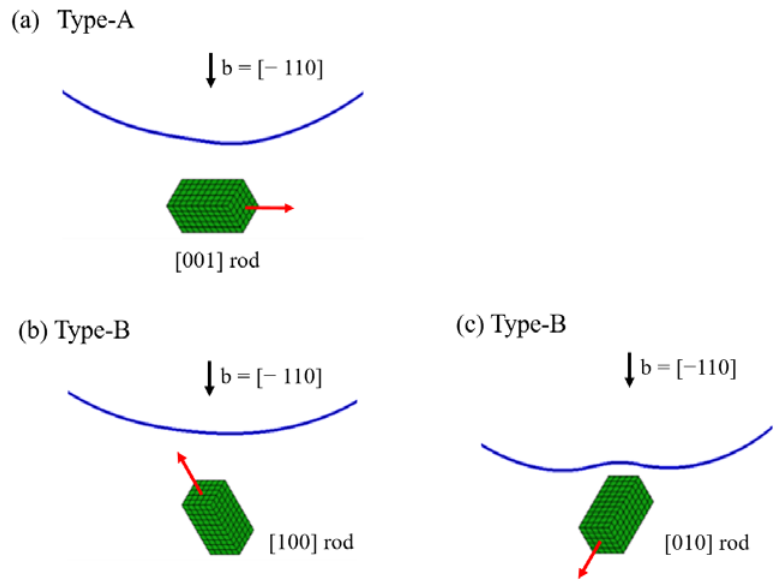
Figure 1. Rods and dislocation on the (111) slip plane. Type-A variant: dislocation Burger’s vector perpendicular to the [001] rod in ( a ). Type-B variants: dislocation Burger’s vector intersecting [100] and [010] rods with an inclined angle in ( b ) and ( c ), respectively.